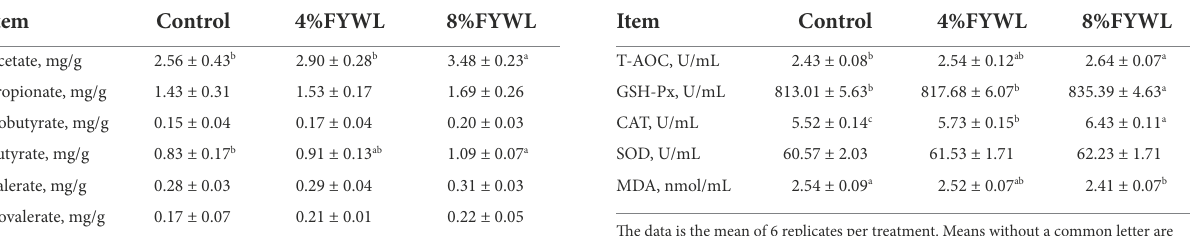
TABLE 7 Effects of FYWL on serum antioxidant ability of finishing